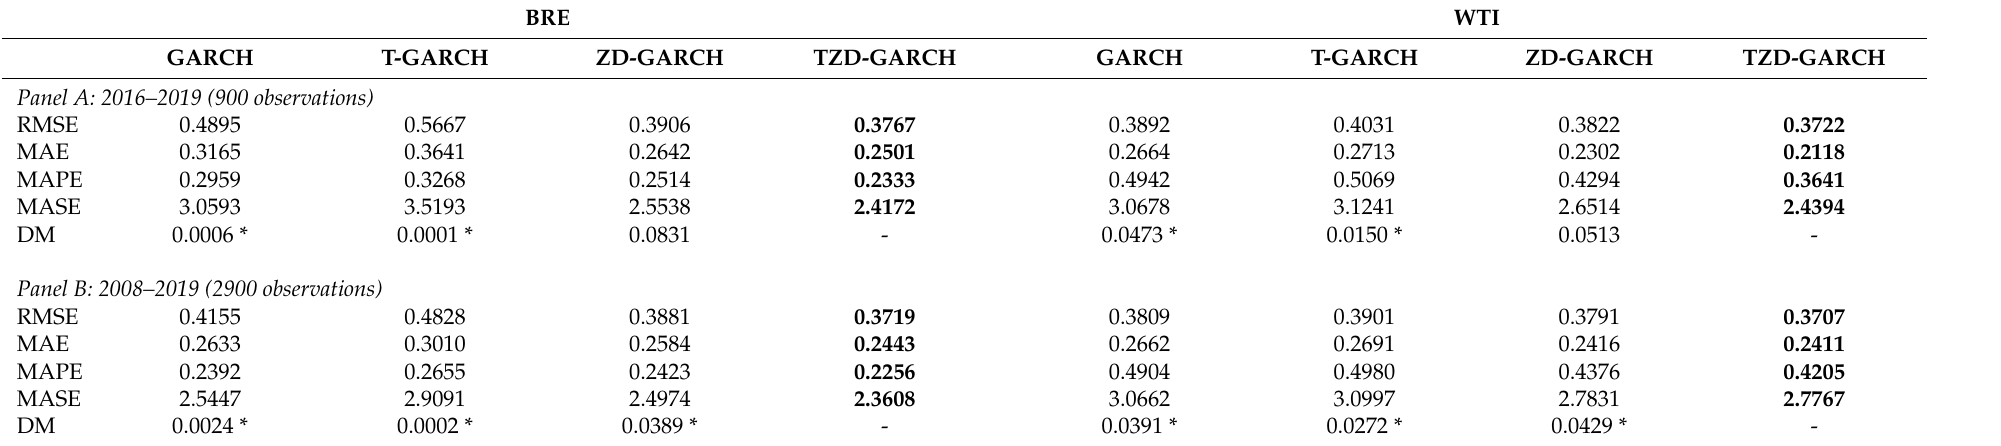
Table 8. Out-of-sample forecasting results (2016–2019 and 2008–2019): BRE and WTI. BRE